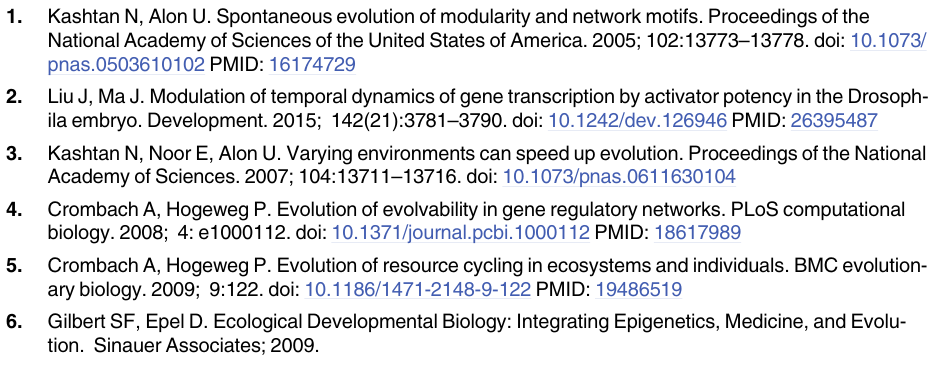
Arrows indicate patterning defects as named in the panel headings (A–C) . Horizontal axes represent %A–P position (where 0% is the anterior pole). Vertical axes show relative protein expression levels (Rel. Prot. Expr.) in arbitrary units (au). T4/6 indicate time classes C14-T4 and T6, respectively.